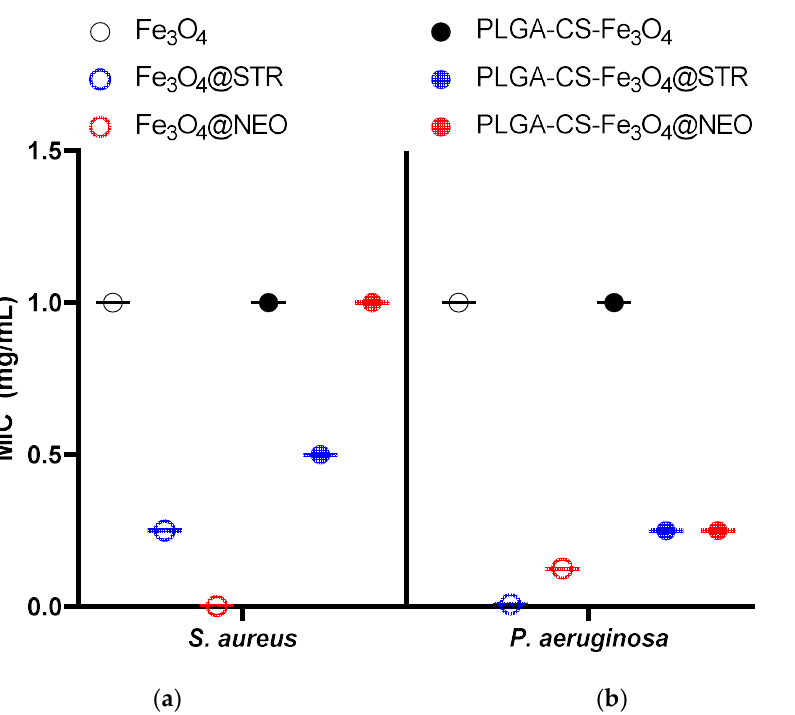
Figure 11. Minimum inhibitory concentration (MIC) of streptomycin- and neomycin-functionalized materials for ( a ) S. aureus and ( b ) P. aeruginosa at 24 h of incubation in standard conditions.